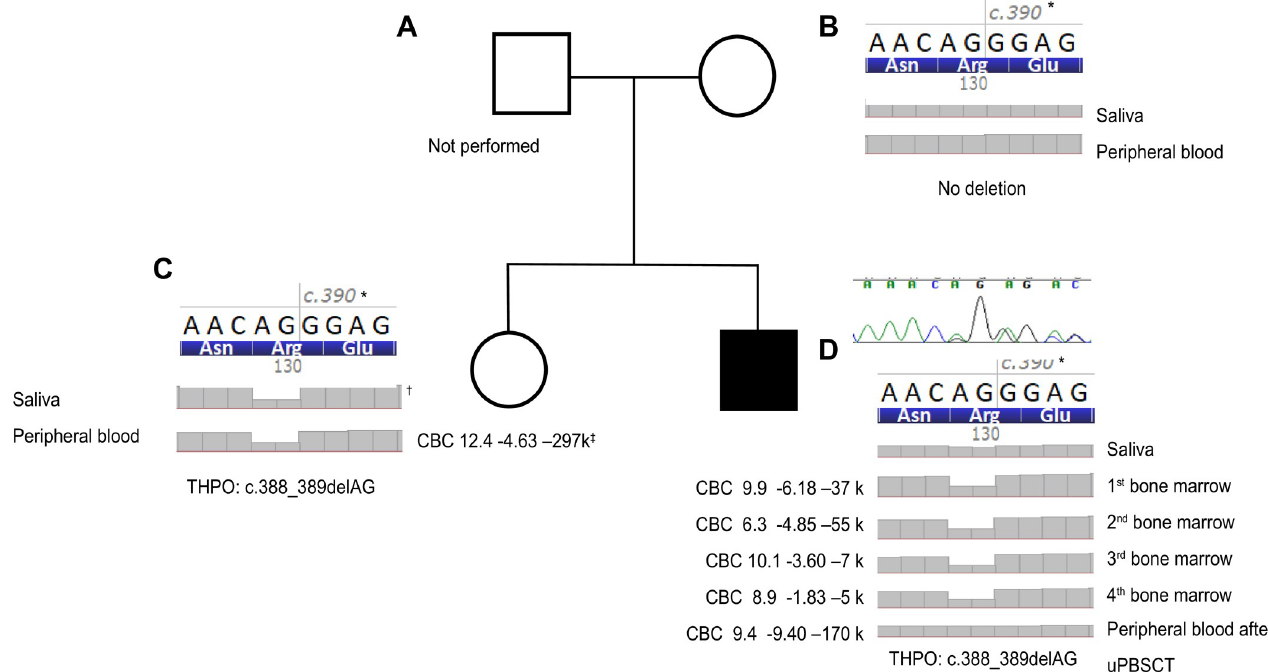
Fig 4. Pedigree of the proband (patient 1) with THPO variants and monoallelic deletion of THPO : c.388_389delAG. (A). The proband’s father was not included in the family study. (B). No THPO deletion was observed in the saliva and peripheral blood samples of the mother. (C). Monoallelic deletion of THPO : c.388_389delAG was observed in the saliva and peripheral blood samples of the sister. (D). Monoallelic deletion of THPO : c.388_389delAG was observed in four consecutive bone marrow and saliva samples of the proband. However, the deletion was not observed in the peripheral blood sample after uPBSCT. Monoallelic deletion of THPO : c.388_389delAG was confirmed by Sanger sequencing in four consecutive bone marrow samples of the proband. CBC: complete blood count; uPBSCT: unrelated peripheral blood stem cell transplantation. � Reference codon and amino acid sequence of NM_001290003.1. are above gray bars. † Gray bars indicate sequencing depth. ‡ CBC shows hemoglobin (x10 3 /L), white blood cells (x10 9 /L) and platelets (x10 6 /L) in order.